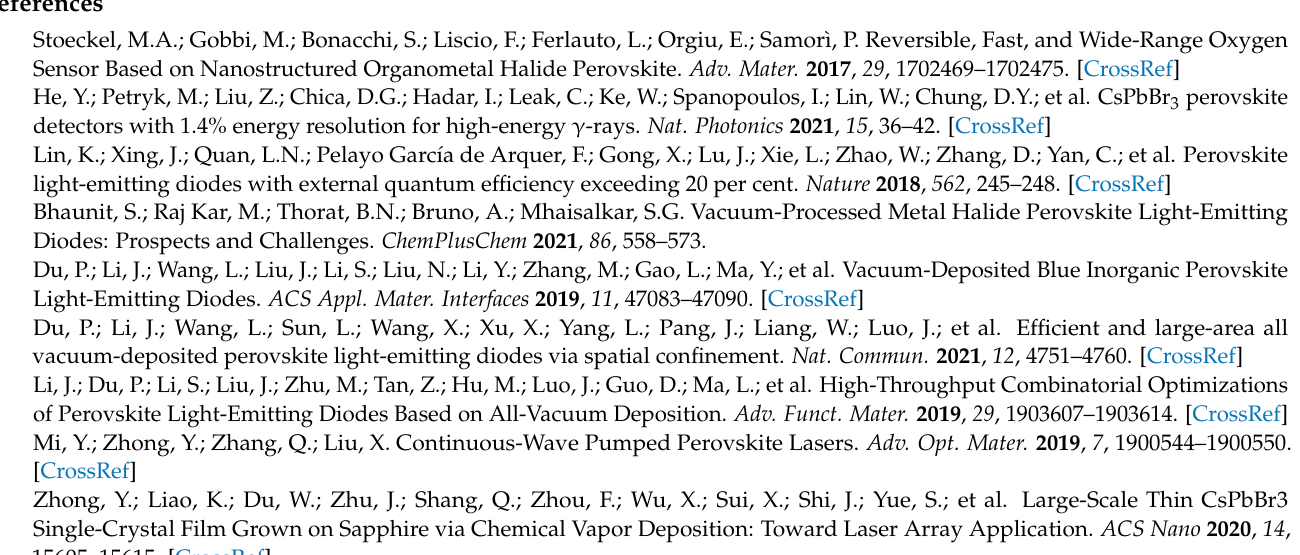
variation due to ASE; Figure S3: complete ASE threshold temperature dependence; Figure S4: energy levels scheme; Figure S5: complete PL intensity temperature dependence; Figure S6: PL peak wavelength and FWHM temperature dependence. Model of the ASE threshold temperature